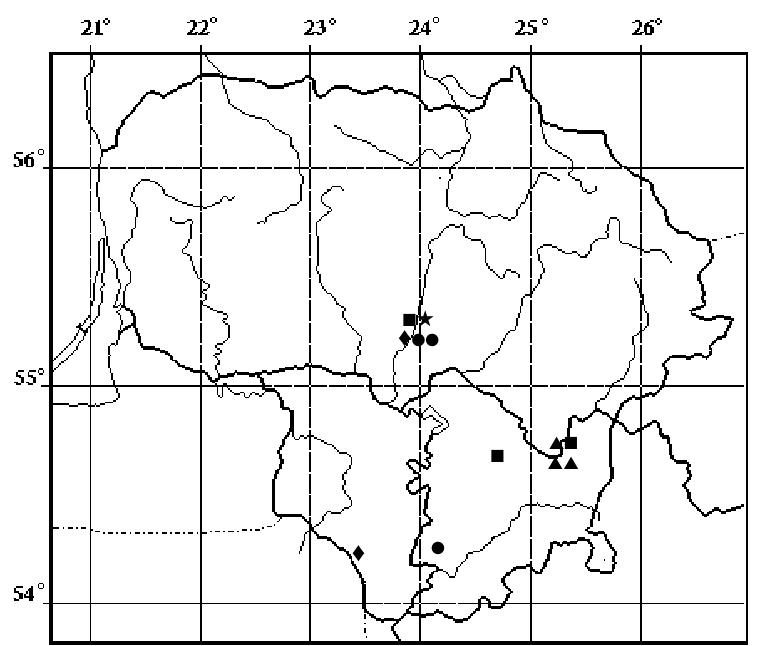
Fig. 2. Localities of Cladorrhinum foecundissimum ( ♦ ), Lateriramulosa uni-inflata ( ▲ ), Dwayaangam cornuta ( ■ ), Pyramidospora herculiformis ( ● ) and Tetraploa setifera ( ★ ) in